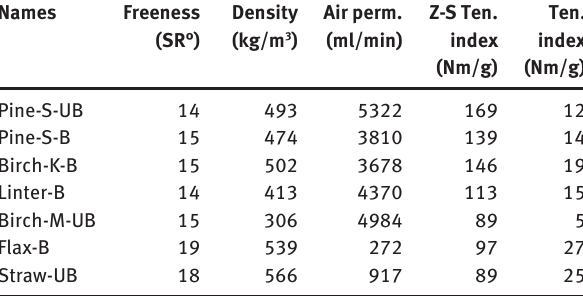
Table 3 Pulps freeness and some properties of handsheets